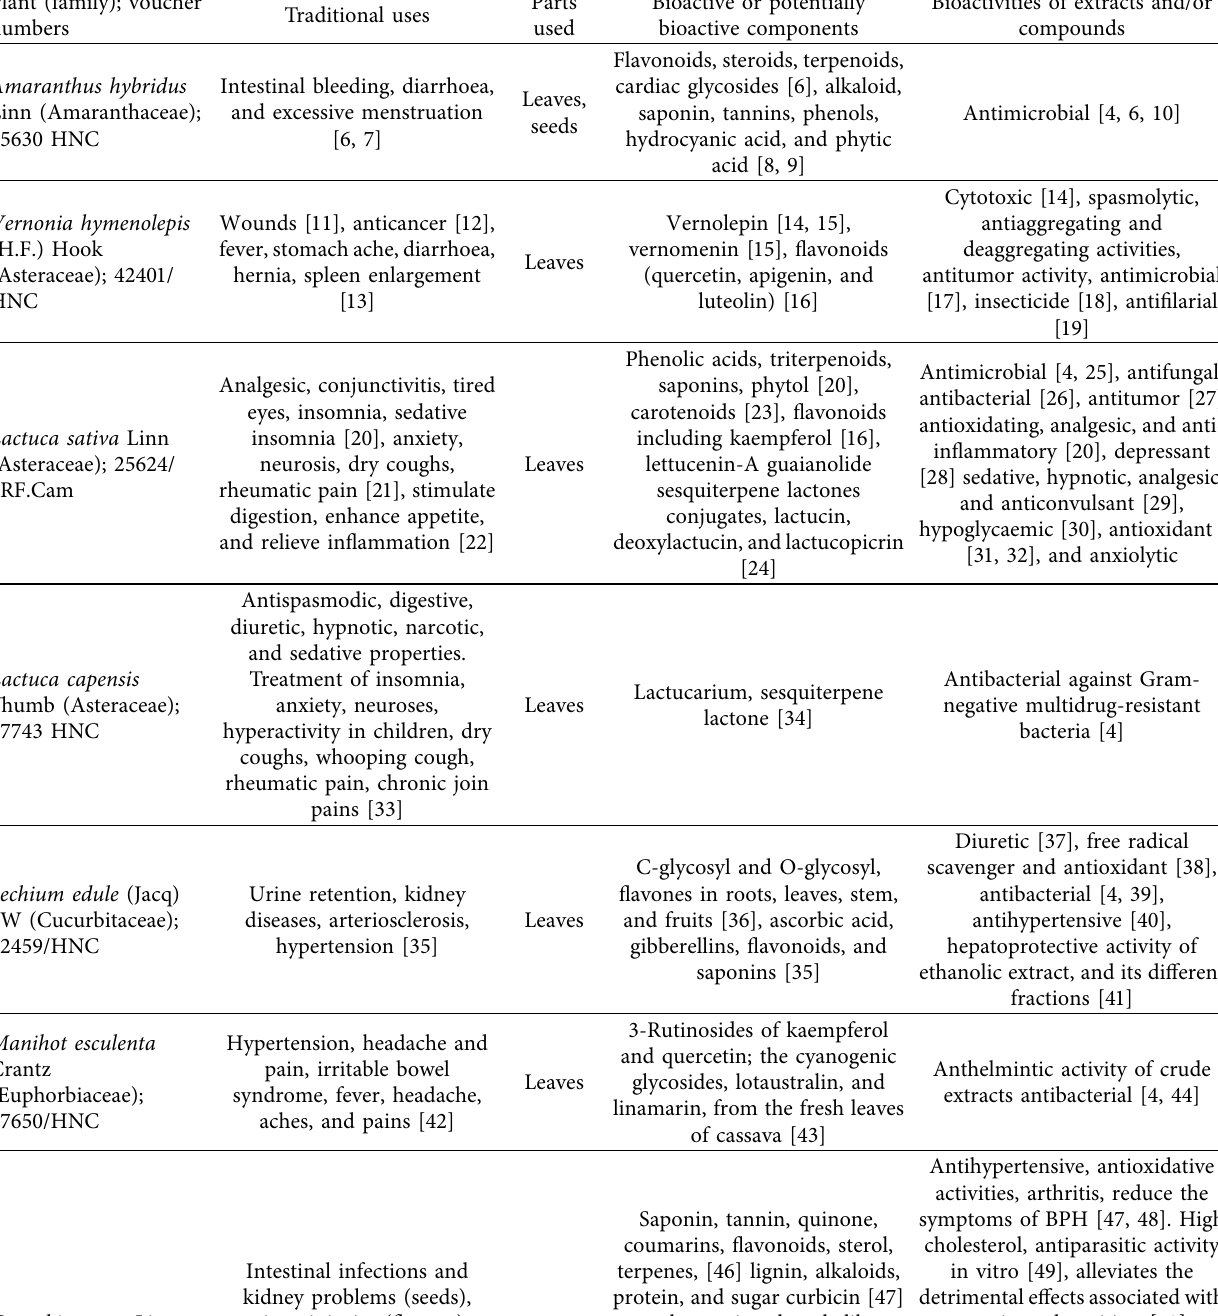
Table 1: Evidence of the activities of the methanol extracts of thirteen antibacterial edible plants. Plant (family);